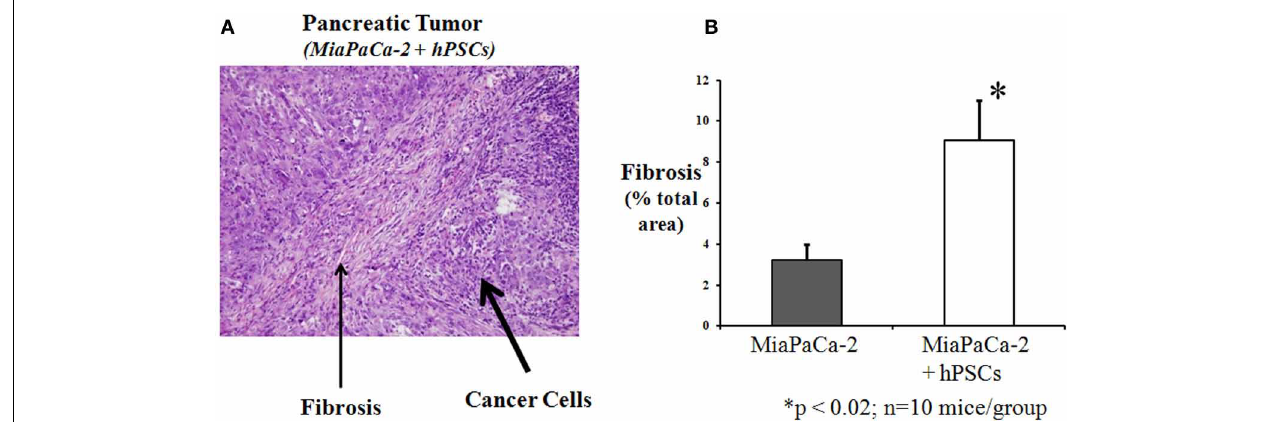
FIGURE 3 | Orthotopic pancreatic tumor produced by injecting a mixture of human pancreatic cancer cells (MiaPaCa-2) and human pancreatic stellate cells into the pancreas of nude mice. (A) H and E staining of tumor section showing prominent areas of fibrosis (desmoplasia) within the tumor. Reprinted with permission Vonlaufen et al. (2008a). (B) Fibrosis was